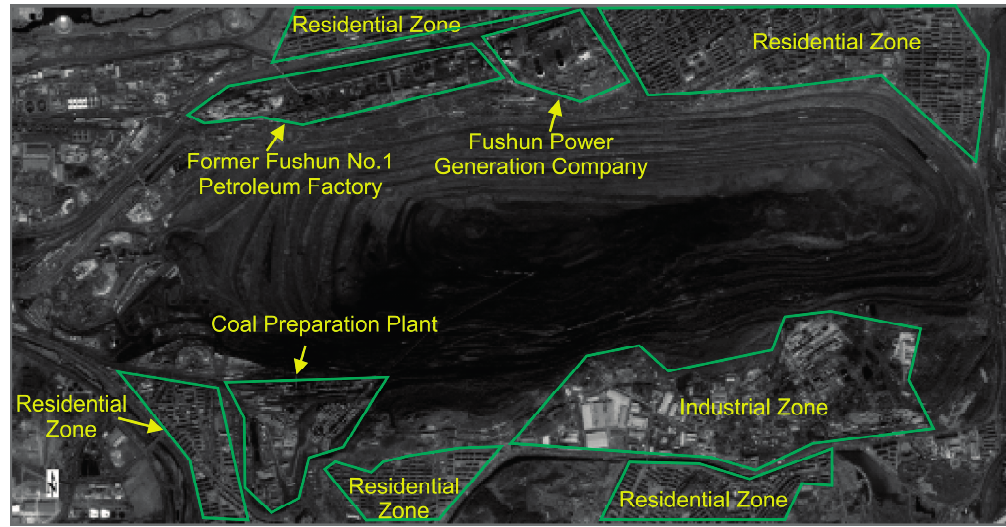
Figure 2. The social economic environment around FWOPM. The green lines indicate the boundaries of residential zones, industrial zone, and factories. The base image was captured by China’s Gaofen-1 satellite in 2014.